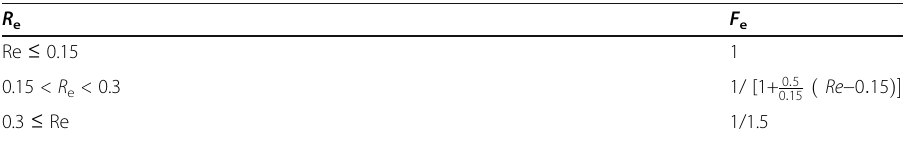
Table 1 basic shape factor F e [16] R